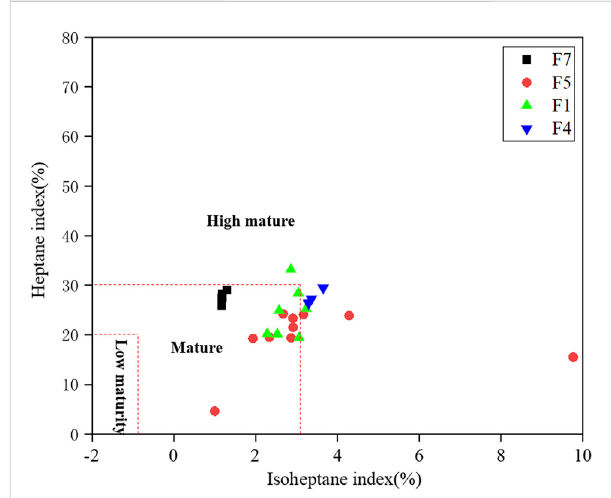
FIGURE 8 Therelationshipbetweentheheptaneindexandtheiso-heptane index of natural gases in Shunbei area (Modi fi ed from Thompson